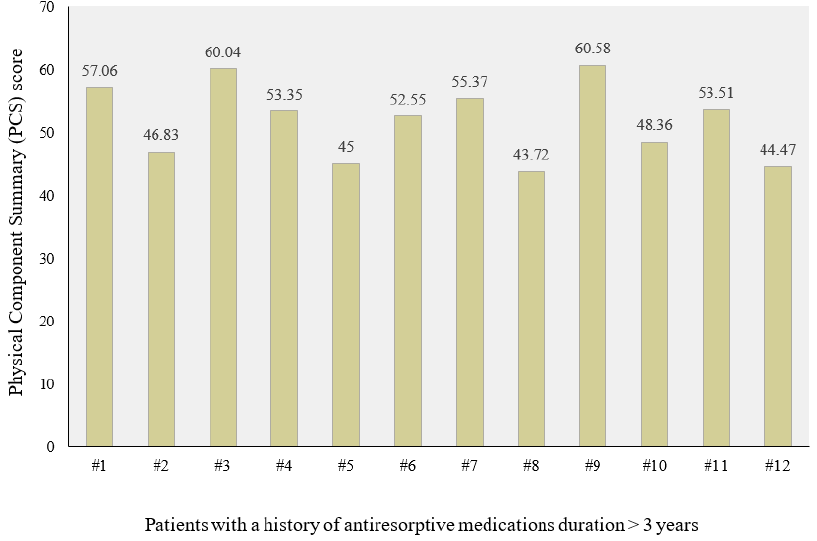
Figure 4. Physical Component Summary (PCS) in patients with a history of anti-resorptive medication duration >3 years.